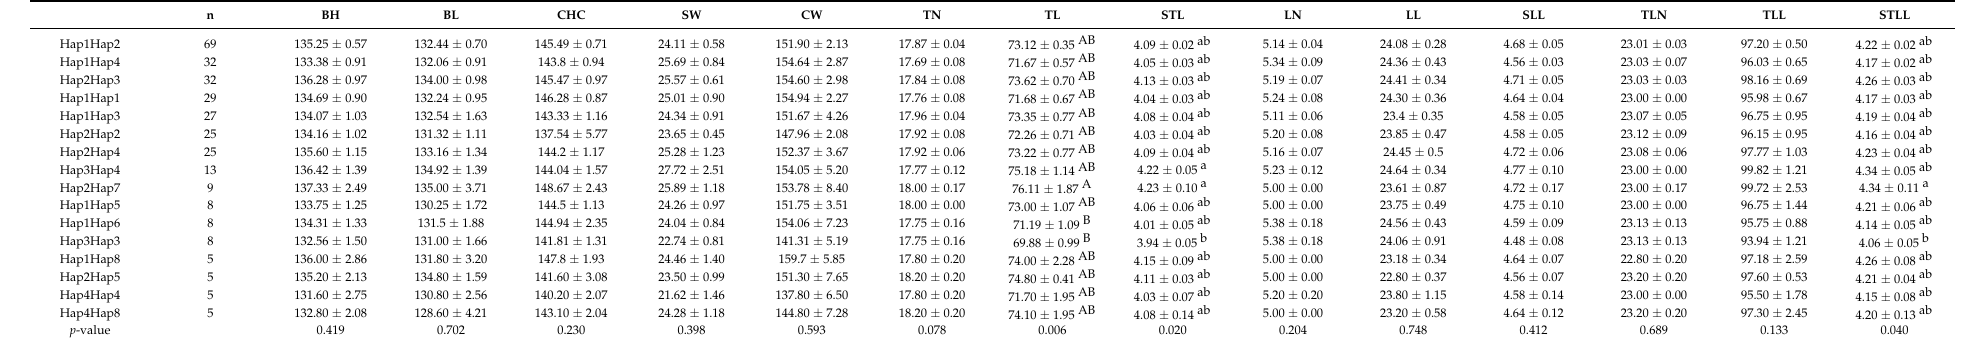
Table 5. Association analysis of Haplotypes of NR6A1 gene and body size traits, slaughter traits and thoracolumbar character in Dezhou